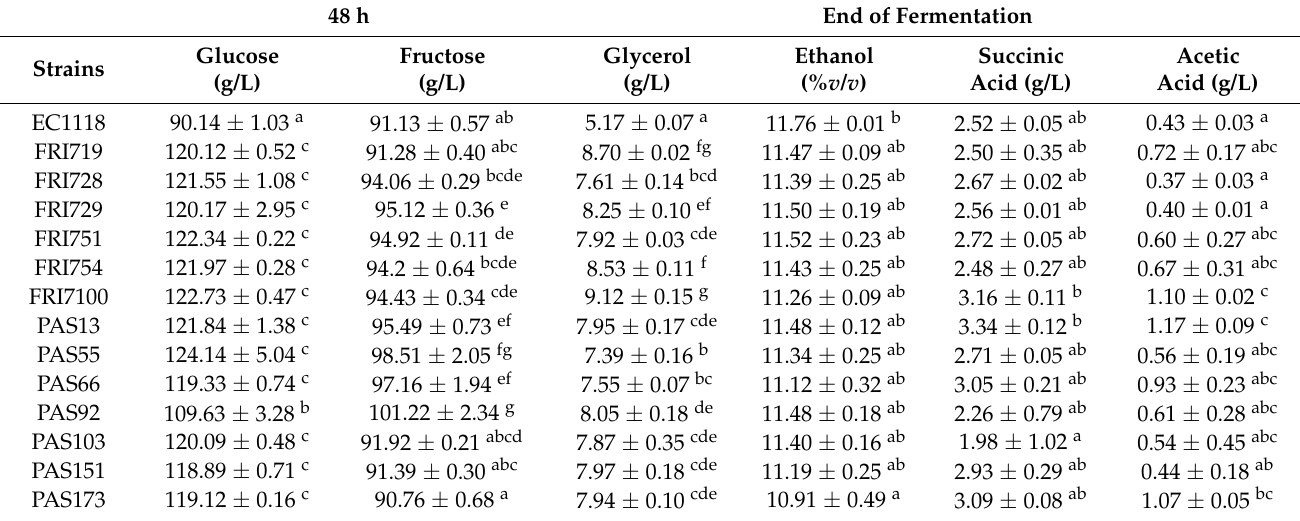
Values are represented by the average and standard deviation ( n = 3). The difference between the averages was analyzed by one-way ANOVA and Tukey post hoc tests. Different letters indicate significant statistical differences p < 0.05 (Tukey’s